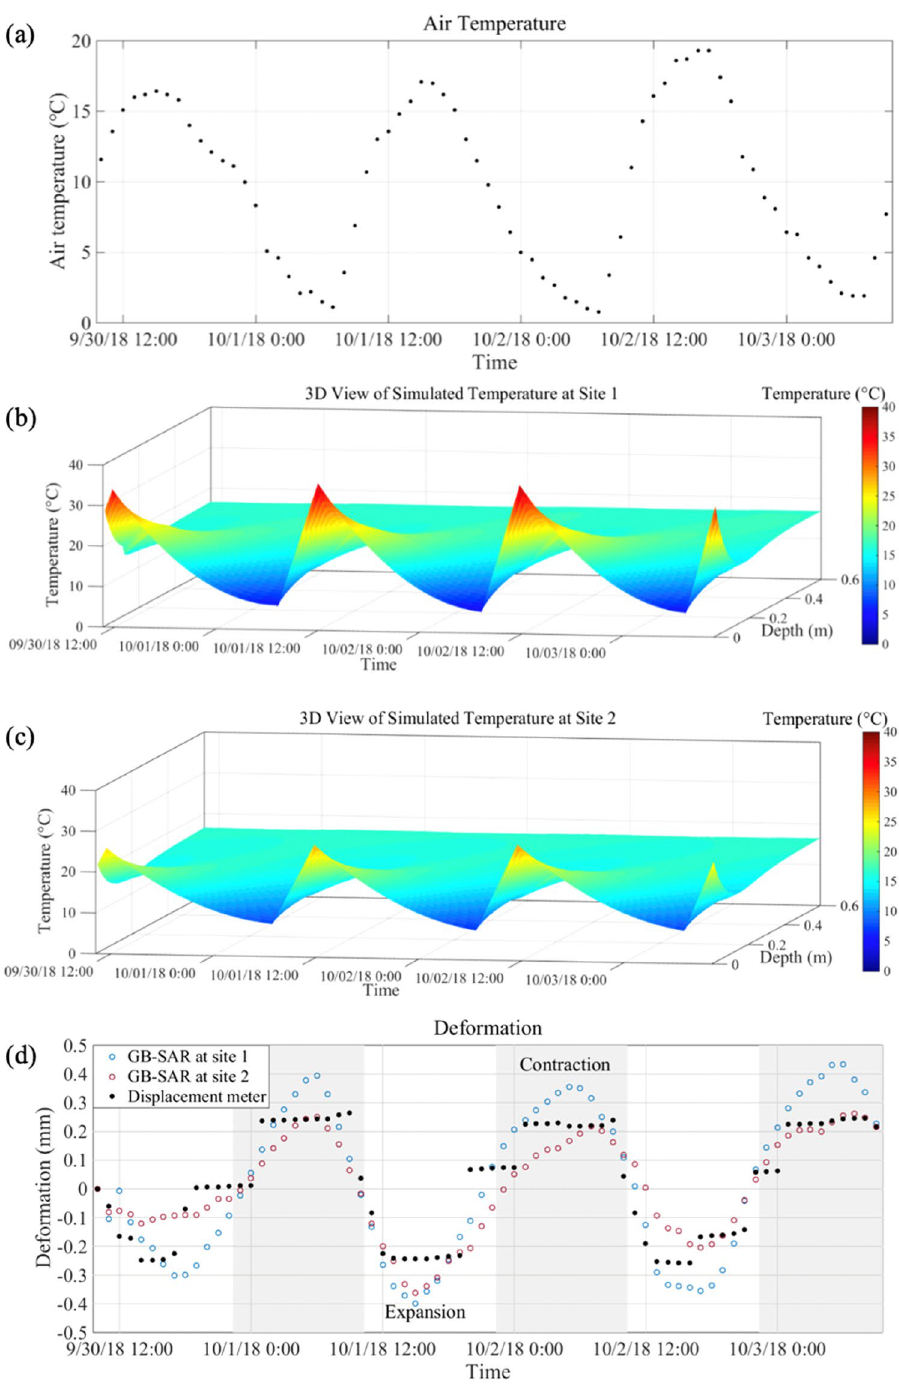
Figure 3. The daily cycle of temperature and deformation over three days from 10:15 on 30 September to 10:14 on 3 October 2018. ( a ) Air temperature. ( b ) and ( c ) 3D view of soil temperature at sites 1 and 2. ( d ) Comparison of deformation measured by the GB-SAR sensor and the displacement meter. Negative and positive values indicate deformation toward and away from the GB-SAR sensor, respectively. Temperature and deformation fluctuation appear to be highly correlated. Air temperature and deformation were sampled every